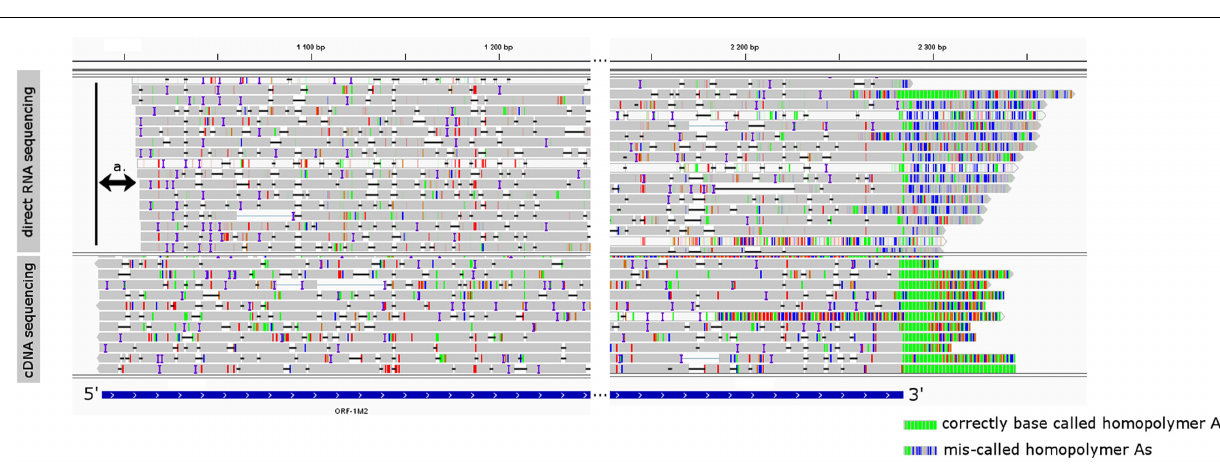
FIGURE 4 | The visual comparison of MinION direct RNA sequencing data with the MinION cDNA sequencing data. The gray rectangles are reads mapped to the genome of PRV representing transcript orf-1M2. Colored lines represent mismatch bases and INDELS. Reads were visualized using IGV, and their 5 (cid:48) and 3 (cid:48) region was cropped for better observation. The blue box represents the annotated orf-1M2 transcript. Double-arrow a. denotes the missing 5 (cid:48) end of the MinION direct RNA sequencing data. On the 3 (cid:48) end of the reads green lines represent homopolymer As in the correctly base called poly(A) tail, while the blue-gray lines in the MinION direct RNA sequencing represent the miscalled nucleotides of the poly(A)